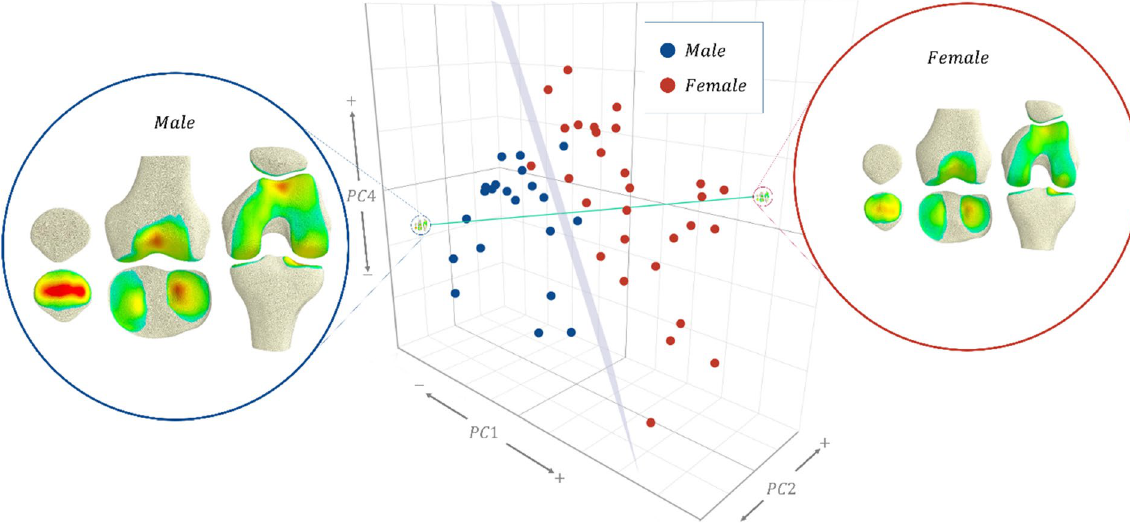
Figure 5. 3D scatter of principal components 1, 2, and 4, of the training set by sex, showing the decision boundary plane (grey) of the logistic regression model, and, a vector (green) that passes through the average male and female